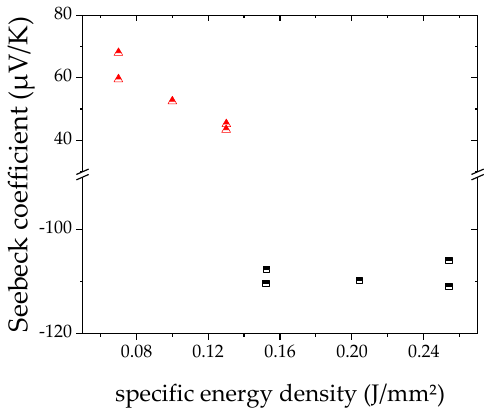
Figure 9. Seebeck coefficient for laser treated bismuth telluride layers (red triangles p-type; black squares n-type).